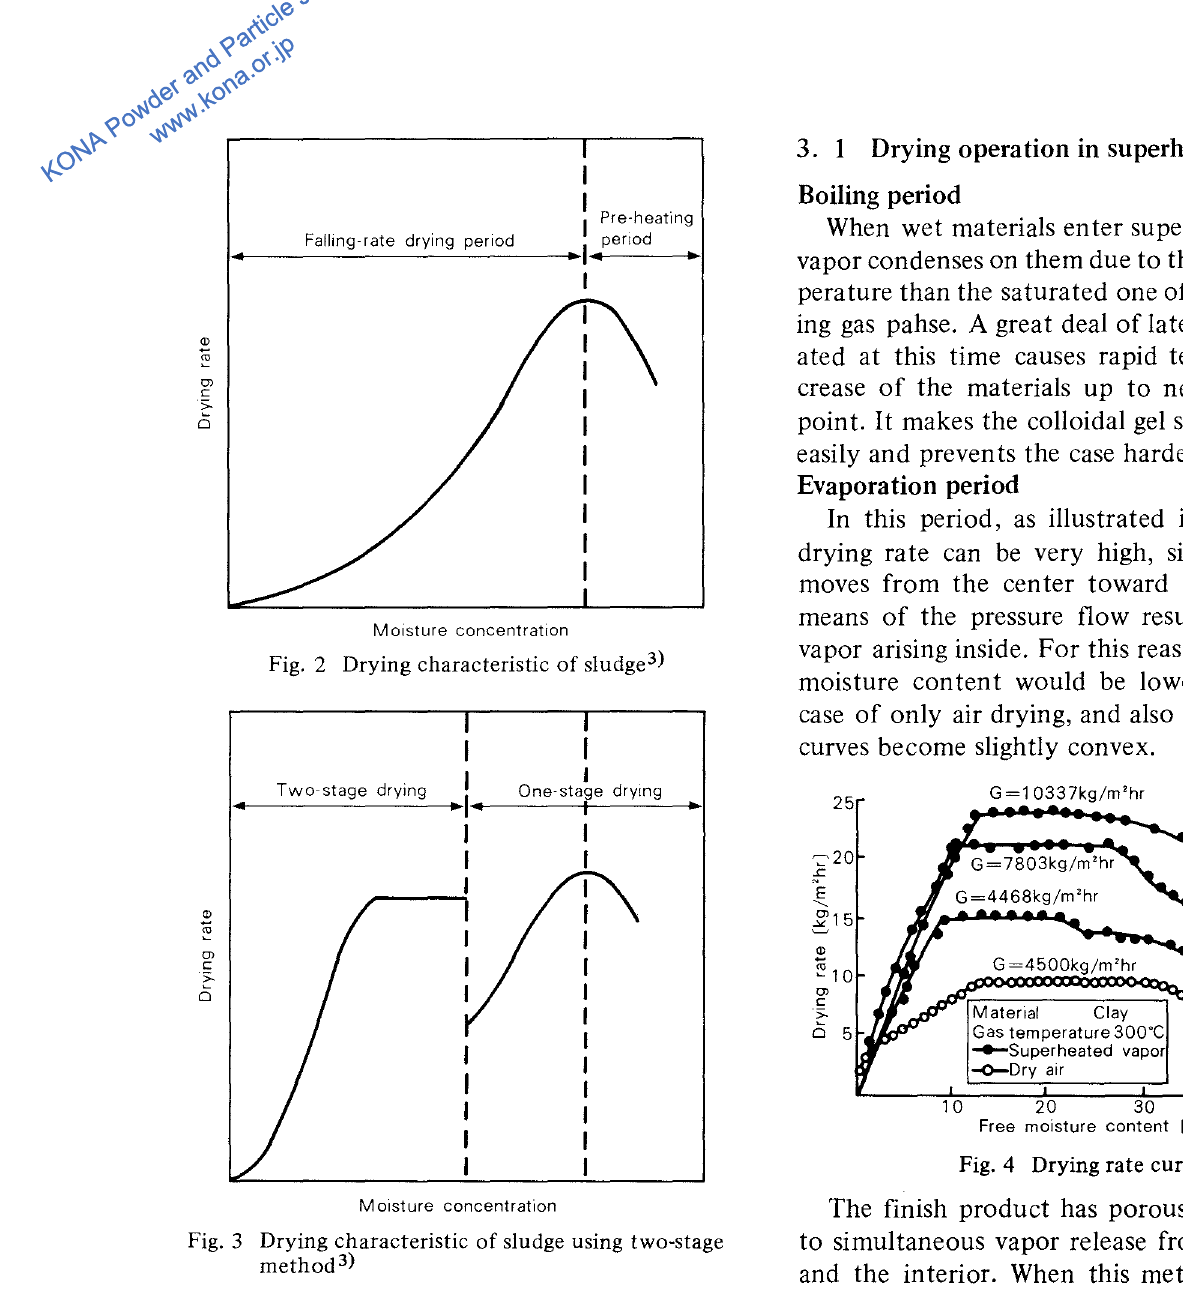
Fig. 3 Drying characteristic of sludge using two-stage method